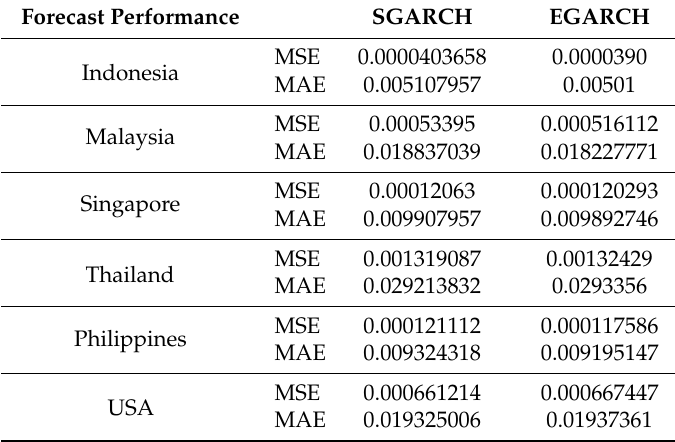
Table 1. Entire ten-year sample. Forecast performance measures of out of sample mean squared errors (MSE) and mean absolute errors (MAE).